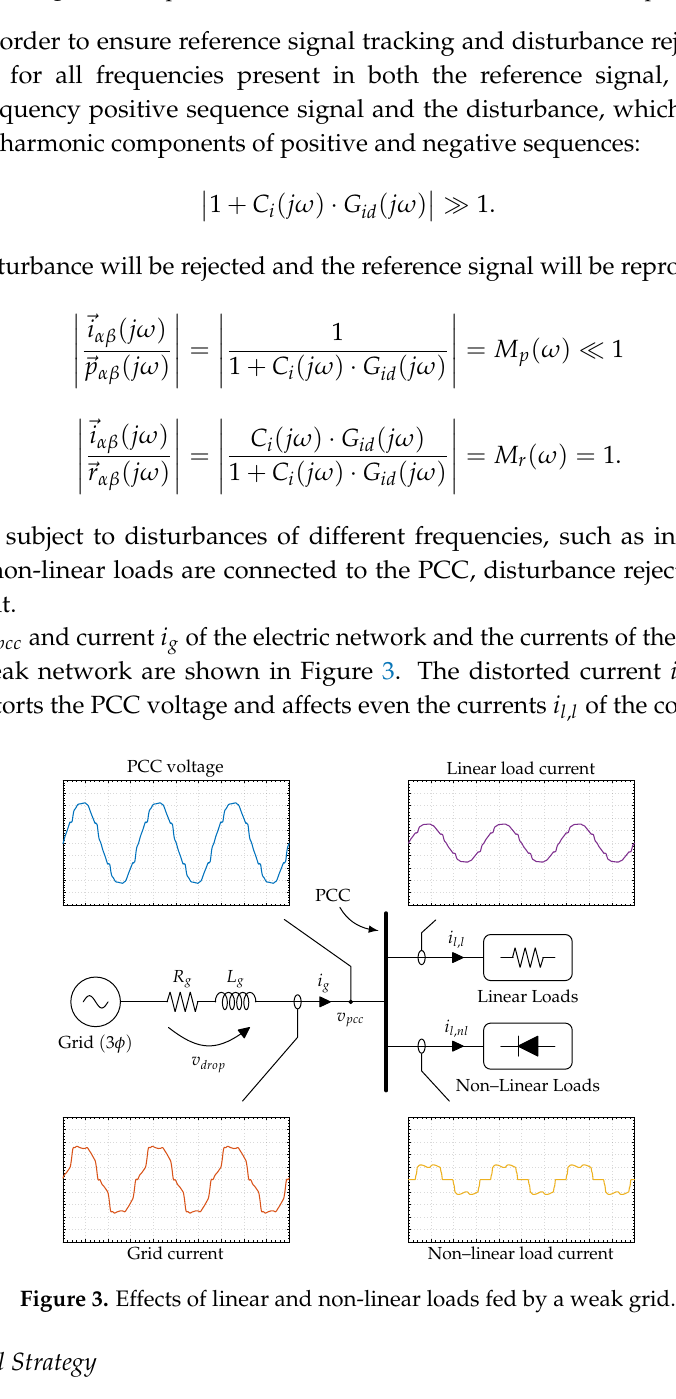
Figure 2. Simplified disturbance model for current control loop.